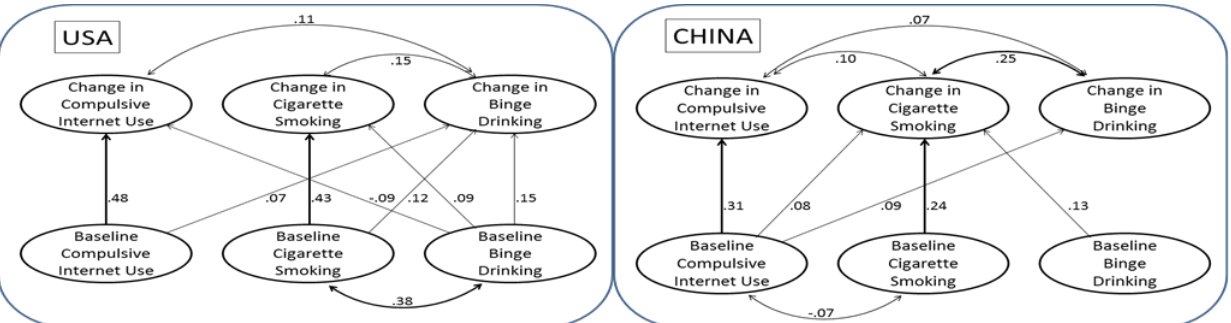
Figure 1. Female students only: Concurrent and longitudinal predictive relationships among CIU, cigarette smoking, and binge